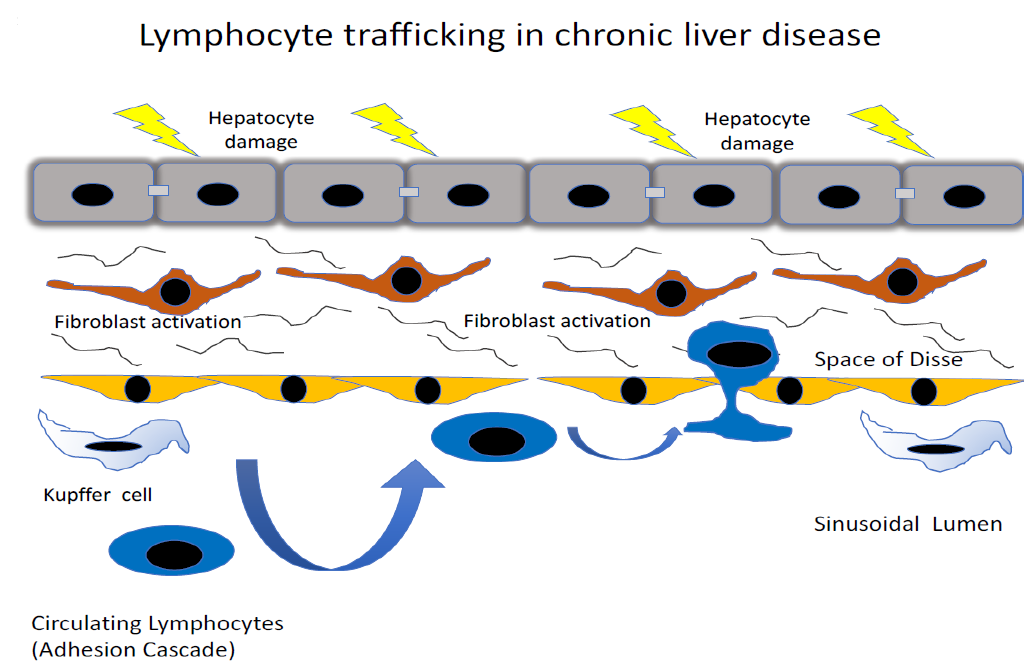
Figure 1. Lymphocyte tra ffi cking in chronic liver disease. Lymphocyte recruitment from the circulation into liver tissue occurs within the low shear specialized channels of the hepatic sinusoids that are lined by hepatic sinusoidal endothelial cells and the macrophage liver resident population, the Kup ff er cells. During liver injury, the signals of damaged epithelial cells lead to activation of hepatic stellate cells in the Space of Disse underneath the sinusoidal endothelium. The sinusoidal endothelium itself is activated and upregulates the expression of adhesion molecules, which promote the recruitment of lymphocytes from circulation in an organ specific manner. This involves an adhesion cascade where lymphocytes in circulation undergo a tethering step leading to firm adhesion and activation on the endothelial surface, followed by their transendothelial migraton into liver